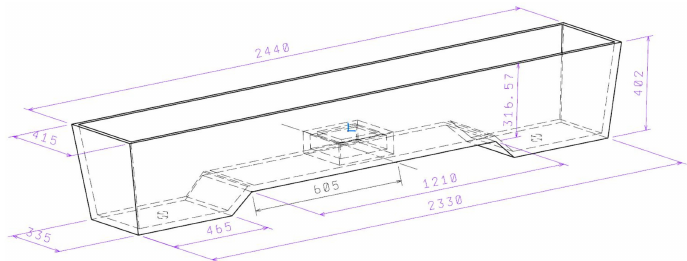
Figure 3. Dimensions of the used model of the tundish equipped with a standard impact